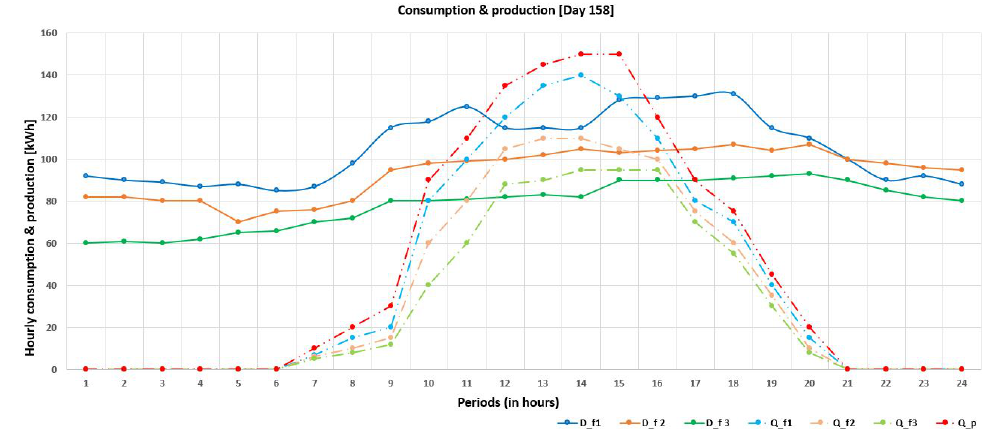
Figure 5. An example of energy consumption and production in a REC for day 158.